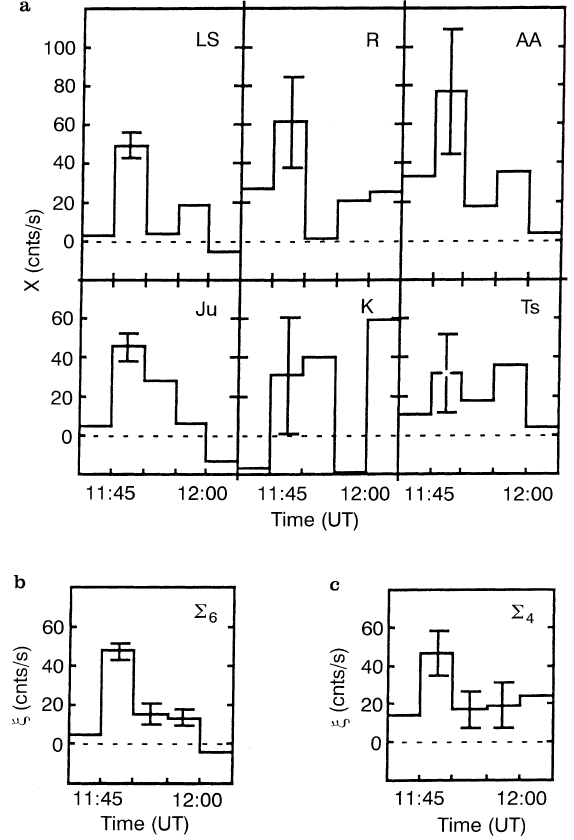
Fig. 3. a Responses of neutron monitors for the solar-neutron event on 3 June 1982 reduced to the standard observational conditions (see text): LS - Lomnick (cid:19) y (cid:20) Stit; R - Rome; AA - Alma-Ata; Ju - Jungfraujoch; K - Kiel; Ts - Tsumeb; b the weighted summed